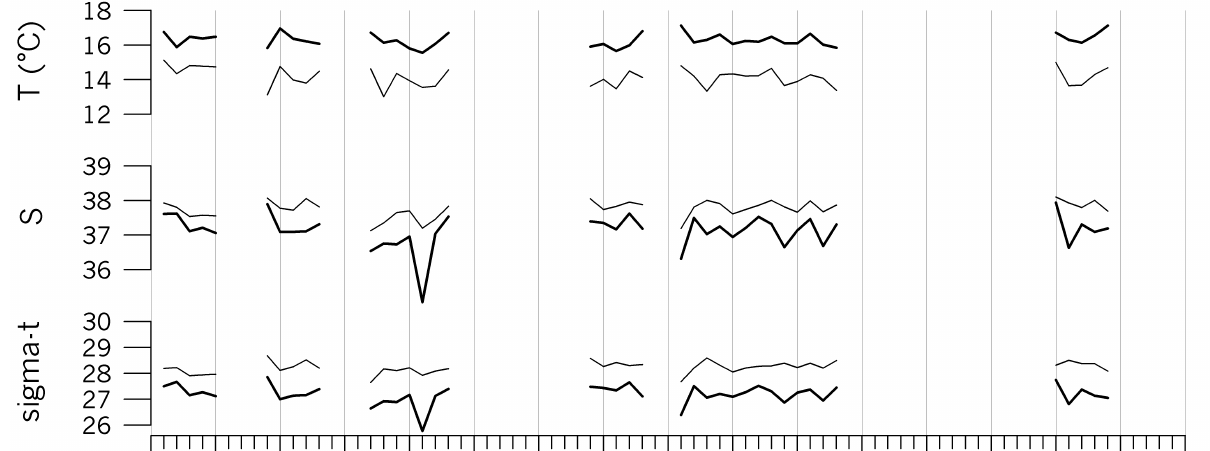
Fig. 4. Yearly means of temperature, salinity and density (sigma-t) for the 1921–2000 interval for the surface (heavy solid line) and the bottom (solid line) layer at station RV001.